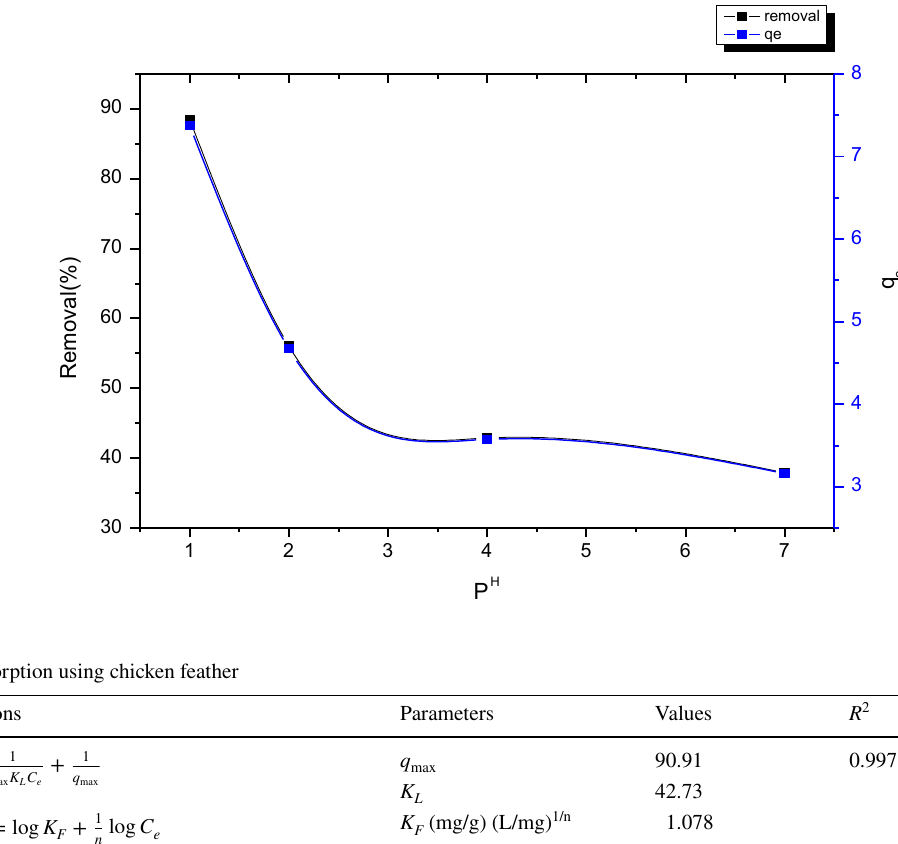
Fig. 8 Effect of P H